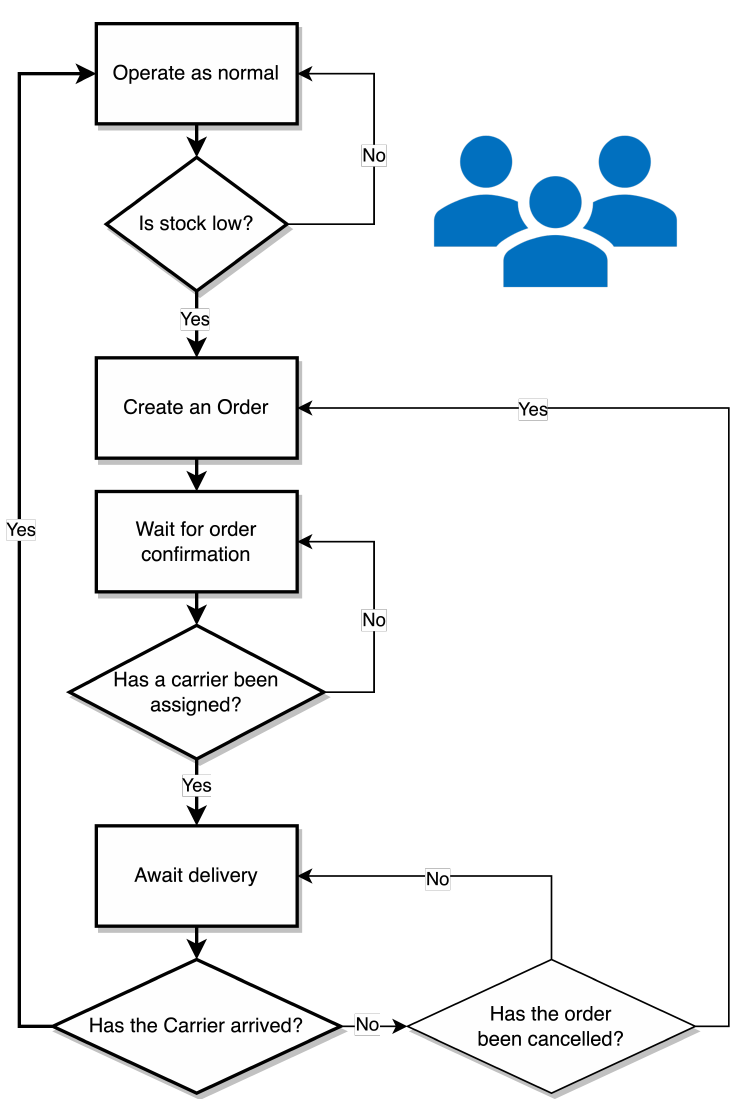
Figure 4. Customer agent